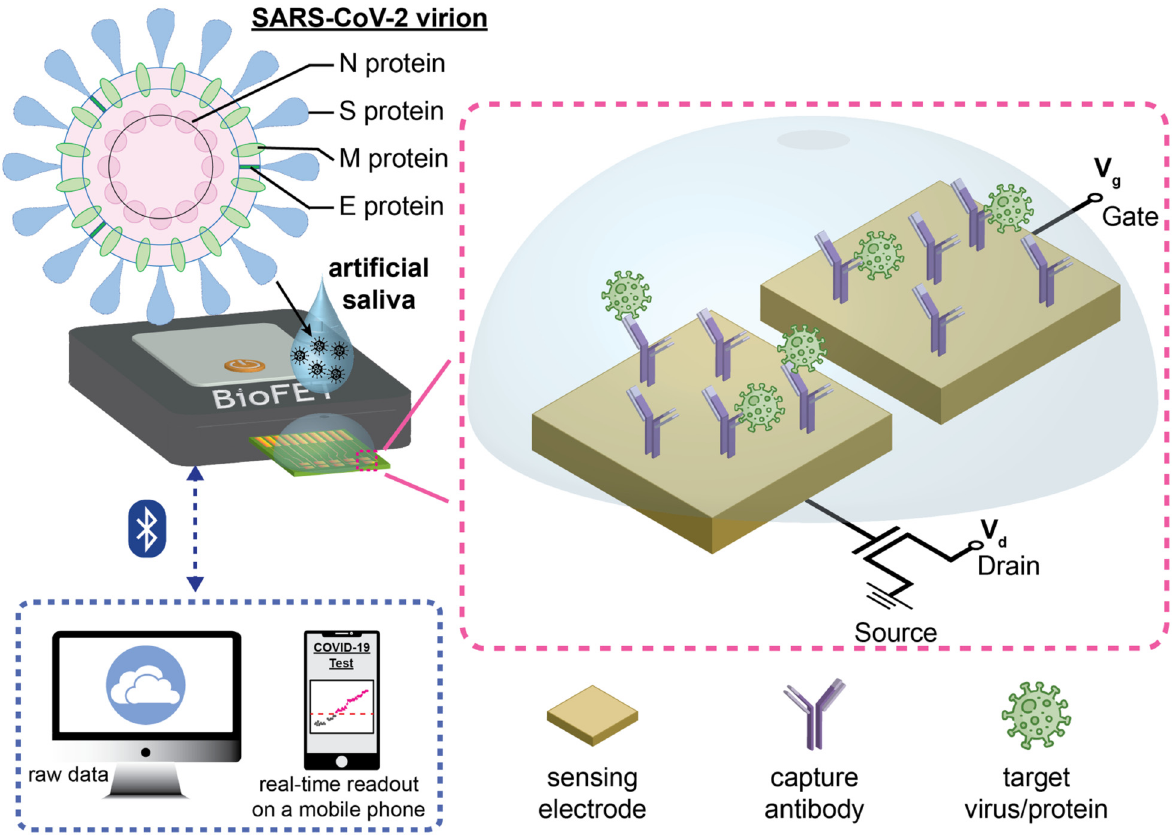
Figure 18: Schematic illustration of a saliva - based COVID - 19 antigen test using an electrical double layer ( EDL )- gated fi eld - e ff ect transistor biosensor ( BioFET ) [ 117 ]